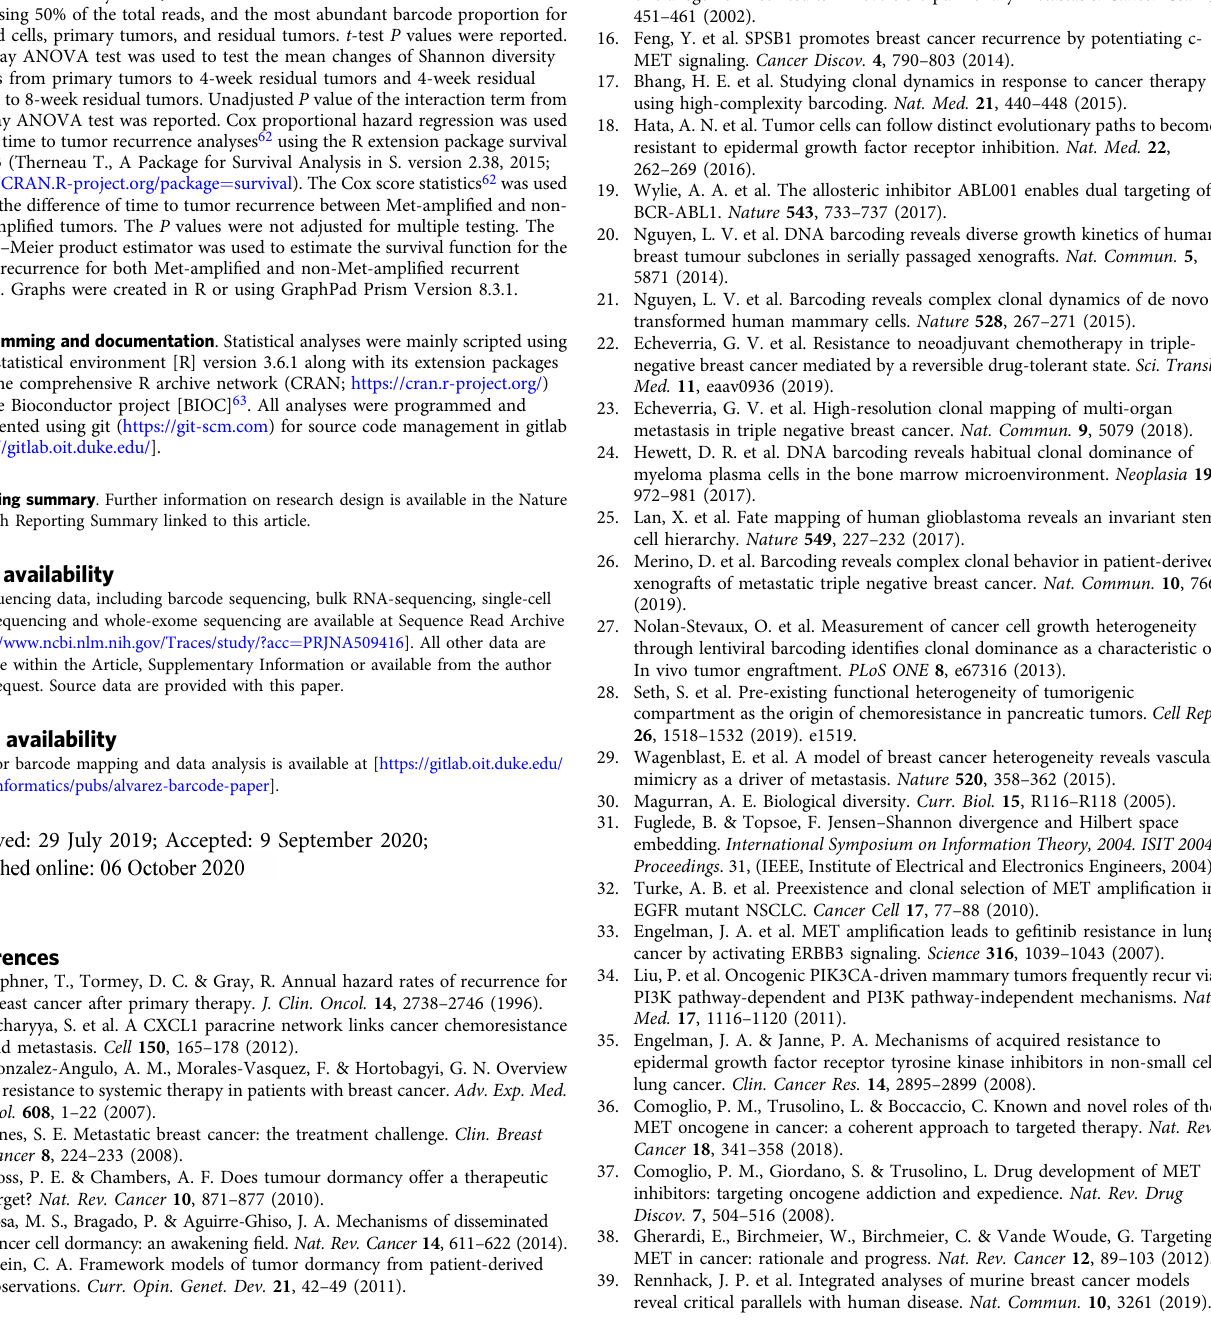
Table 4. The aligned reads were mapped to genomic features using HTSeq 57 , implemented in the STAR program. The reference sequence and GTF fi le were obtained from the NCBI GRCm38 bundle available from the iGenomes collection. Gene differential expression was performed within the framework of a negative binomial model using R (v3.4.4) (R Core Team, R: A Language and Environment for Statistical Computing. 2016: Vienna, Austria.) and its extension package DESeq2 (v1.18.1) 58 . PCA analysis were performed for each of the cohort based on the normalized reads matrix (based on rlog from DESeq2(v1.18.1)) from the DESeq2 (v1.18.1). For whole-exome sequencing analysis, single-nucleotide variants (SNVs) and CNAs were detected using standard approaches 59 . Brie fl y, Mutect2 60 was used to call non-synonymous SNVs by comparing whole-exome sequencing data against matched normal DNA, and CNAs were identi fi ed using CODEX2 61